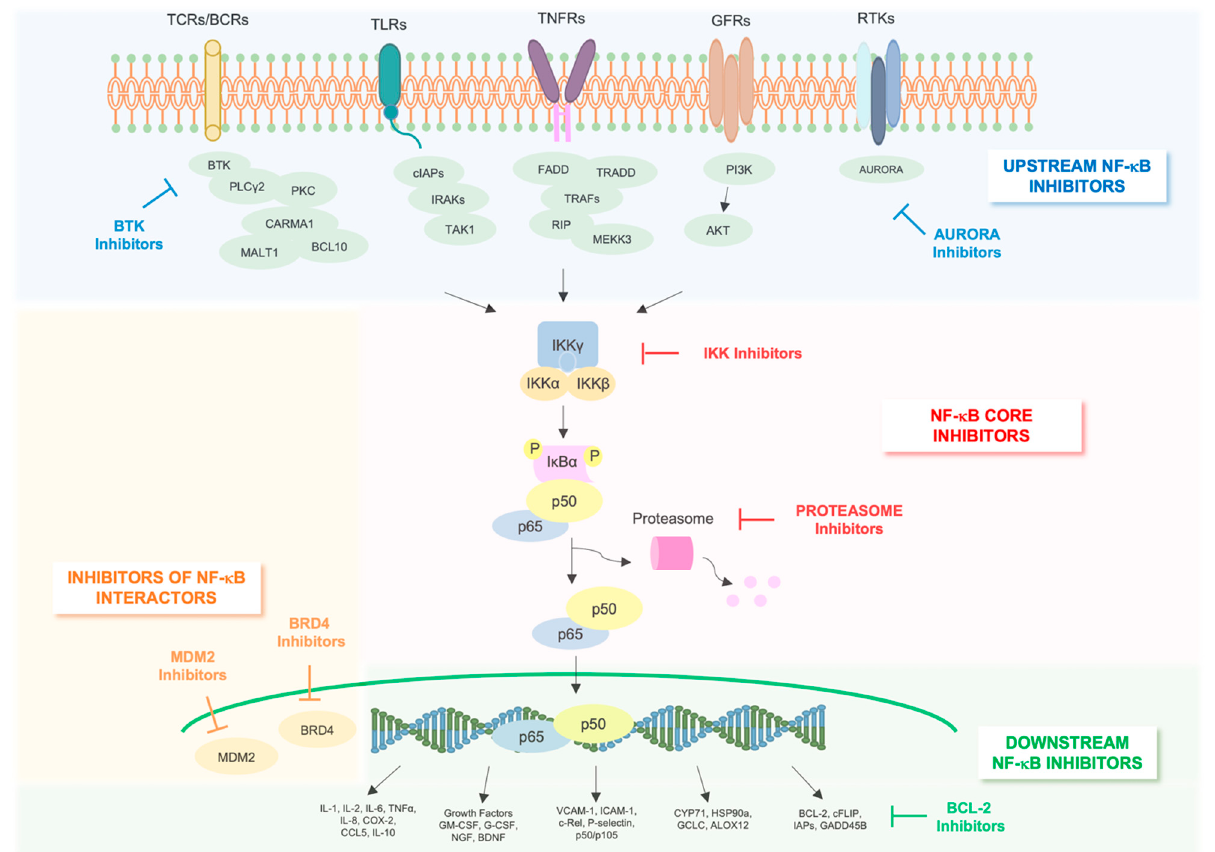
Figure 3. Strategies for therapeutic inhibition of NF- κ B canonical pathway in AML. Depicted is the mode of action of major NF- κ B inhibitors that are in preclinical development or used in the clinic.